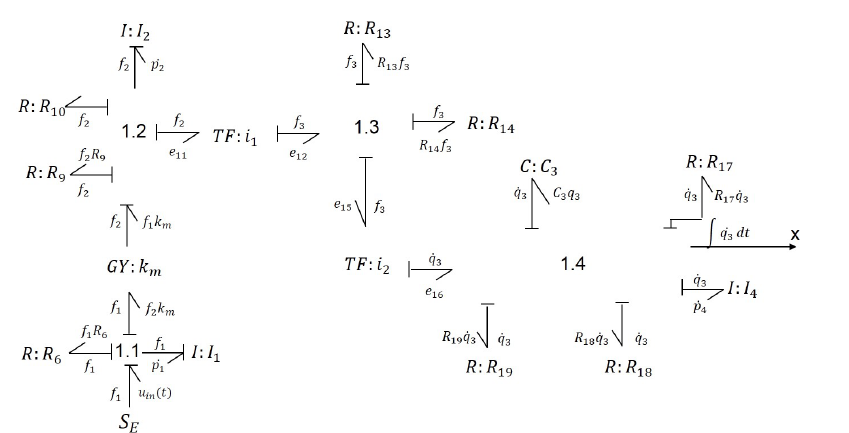
Figure 6. Causal bond graph of the ACV Figure 5. Bond graph of the ACV actuator